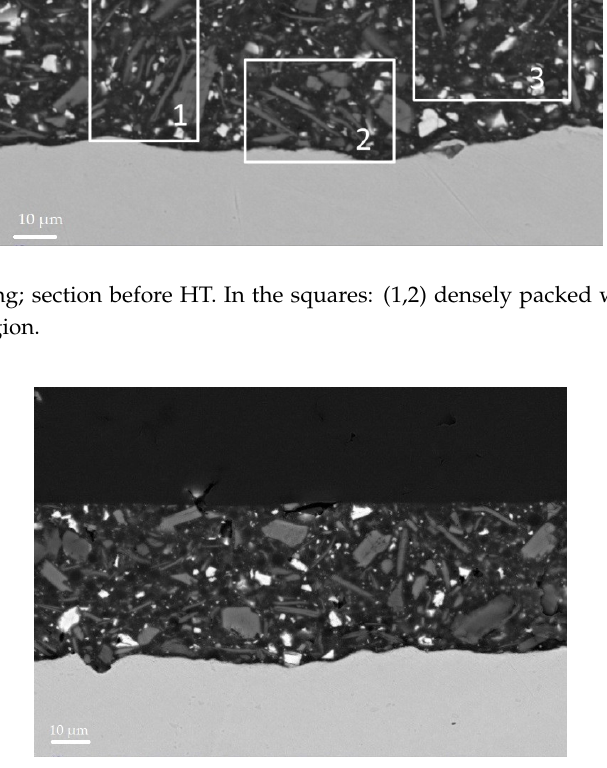
Figure 13. ( a ) SEM ‐ EDS images at high magnification of S6 coating before HT. SEM, and ( b ) EDS analysis of S6 details, highlighted by yellow circles in the SEM image.